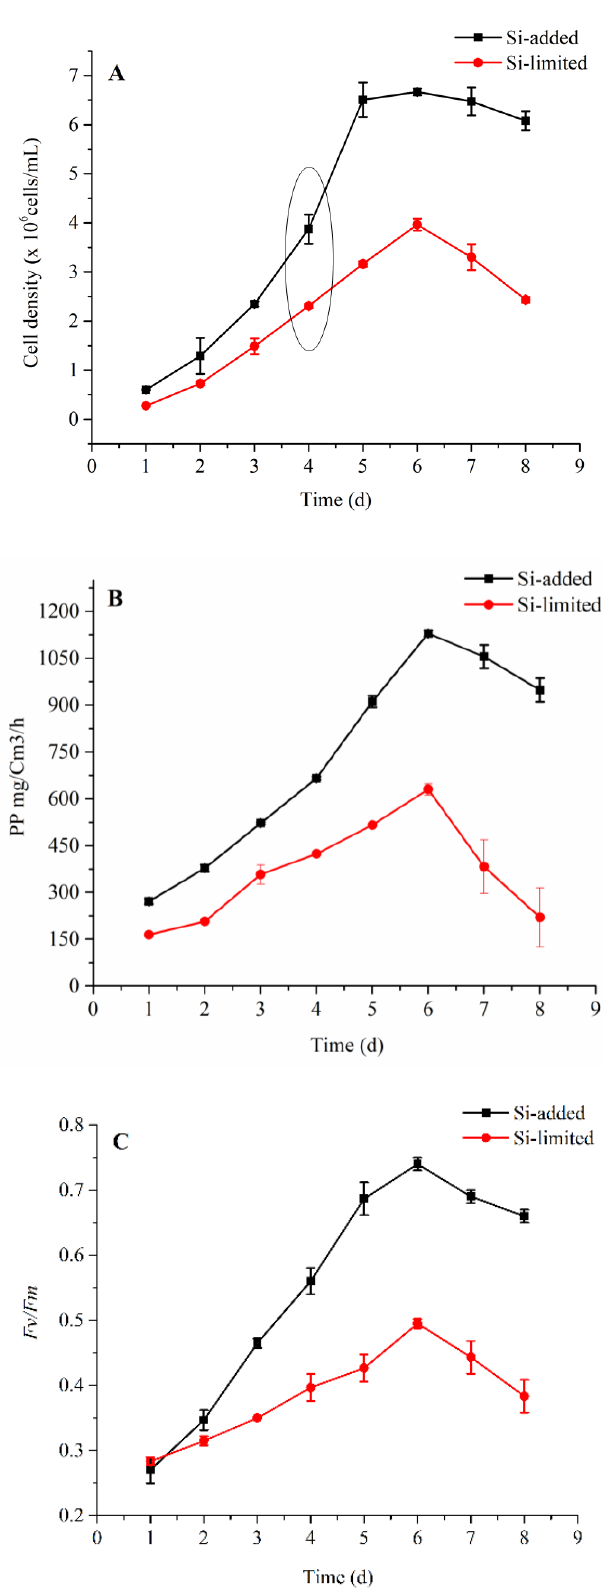
Figure 1. Cell density, net primary productivity, and photosynthetic efficiency in Si-limited and Si-added samples of S. dohrnii. Cell density ( A ), net primary productivity ( B ) and photochemical quantum yield of PS II ( FV / FM ) ( C ). The circle in Figure A shows the duration of sample collection for iTRAQ proteomics. The error bars represent the standard errors from triplicate measurements.